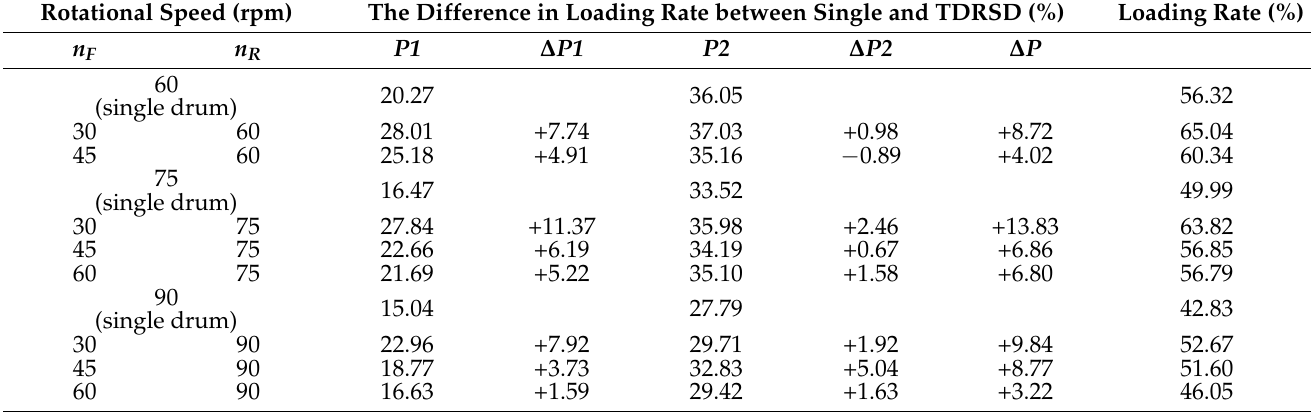
Table 4. The difference in coal loading rate between single and TDRSD and particles’ value in P1 and P2 . Rotational Speed (rpm) The Difference in Loading Rate between Single and TDRSD (%) Loading Rate (%)